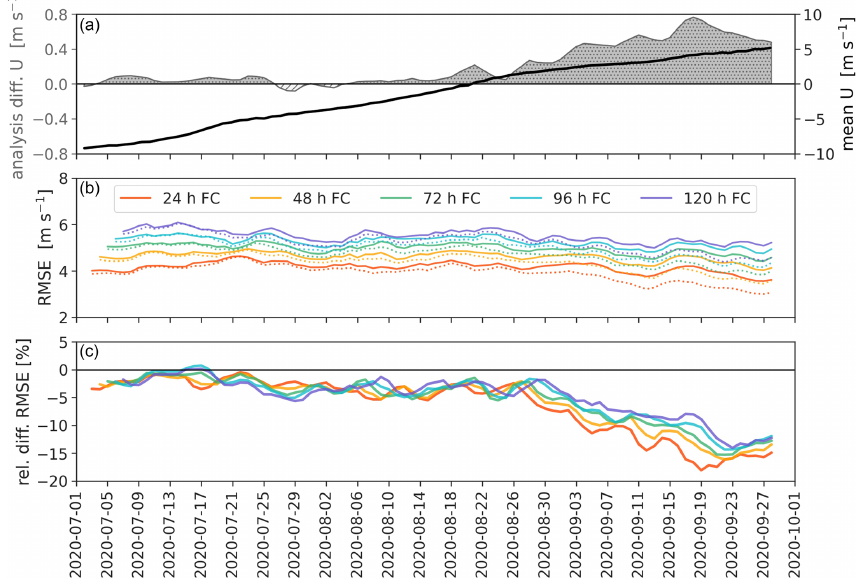
Figure 2. Time series for the tropical belt ± 10 ◦ latitude between 30 and 50hPa. (a) The mean zonal wind (black line) and the mean analysis differences in the zonal wind between EXP_A and CTRL (shaded grey). (b) The RMSE for forecast (FC) lead times from 24 to 120h for the CTRL (solid line) and the EXP_A (dotted line) run. (c) Relative differences in RMSE between EXP_A and CTRL for forecast lead times from 24 to 120h.